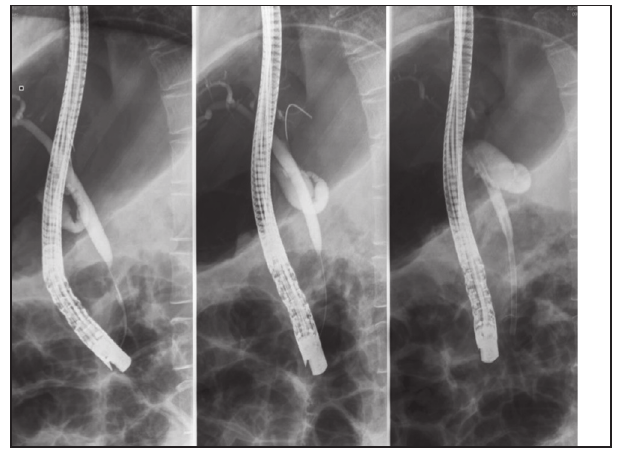
spleen-sparing distal pancreatectomy. Pathological analysis of resected